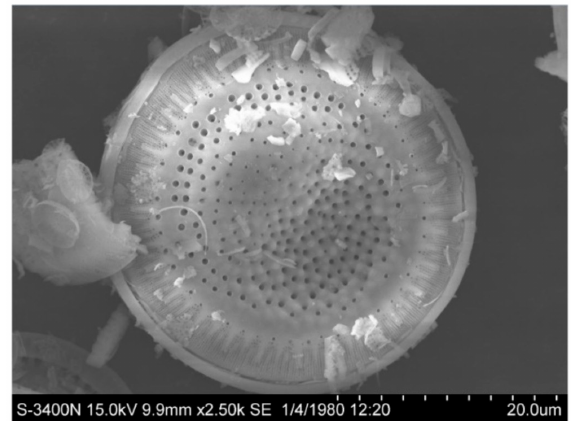
Figure 3. Scanning electron microscope (SEM) image of diatomite.